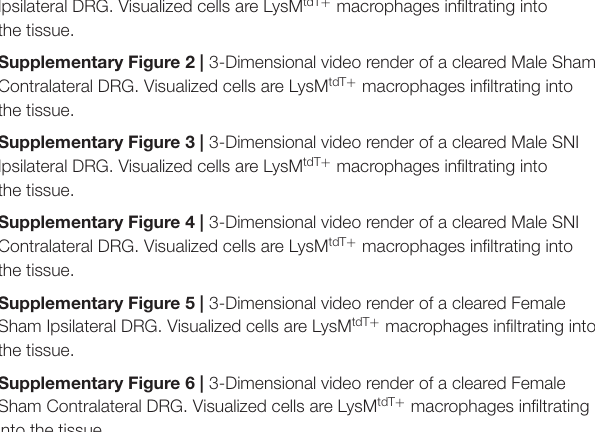
Supplementary Figure 1 | 3-Dimensional video render of a cleared Male Sham Ipsilateral DRG. Visualized cells are LysM tdT + macrophages infiltrating into the tissue. Supplementary Figure 2 | 3-Dimensional video render of a cleared Male Sham Contralateral DRG. Visualized cells are LysM tdT + macrophages infiltrating into the tissue. Supplementary Figure 3 | 3-Dimensional video render of a cleared Male SNI Ipsilateral DRG. Visualized cells are LysM tdT + macrophages infiltrating into the tissue. Supplementary Figure 4 | 3-Dimensional video render of a cleared Male SNI Contralateral DRG. Visualized cells are LysM tdT + macrophages infiltrating into the tissue. Supplementary Figure 5 | 3-Dimensional video render of a cleared Female Sham Ipsilateral DRG. Visualized cells are LysM tdT + macrophages infiltrating into the tissue. Supplementary Figure 6 | 3-Dimensional video render of a cleared Female Sham Contralateral DRG. Visualized cells are LysM tdT + macrophages infiltrating into the